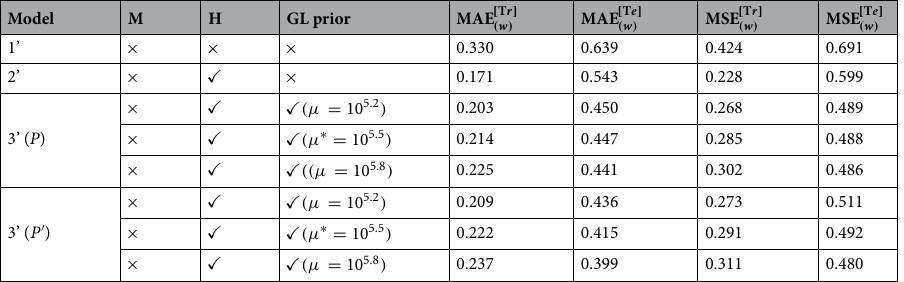
Table 10. Training and testing errors of Models 1’–3’ for real-world data in Europe. The formulas of errors are detailed in Sect. B (Eq. (S5)) of Supplementary Information. The remarks for Columns 2–4 are the same as those in Table 4. In addition, the choice of µ = 10 5.2 , 10 5.5 , and 10 5.8 in Model 3’ has been explained in Fig. 13. Note that the validation errors are minimized at µ ∗ = 10 5.5 as shown in Fig. 17. The partitions in Model 3’ are P and P ′ respectively. P and P ′ are two different partitions of countries in Europe introduced in “Models to compare”.